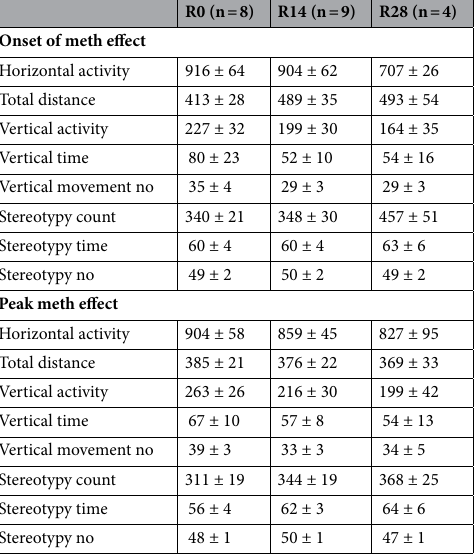
Table 3. Saline/vehicle rats behavioral outcomes (mean ± SEM). Verification that the controls are similar across all time points. Capacity of meth to alter motor activity is the same regardless of when the animals received the